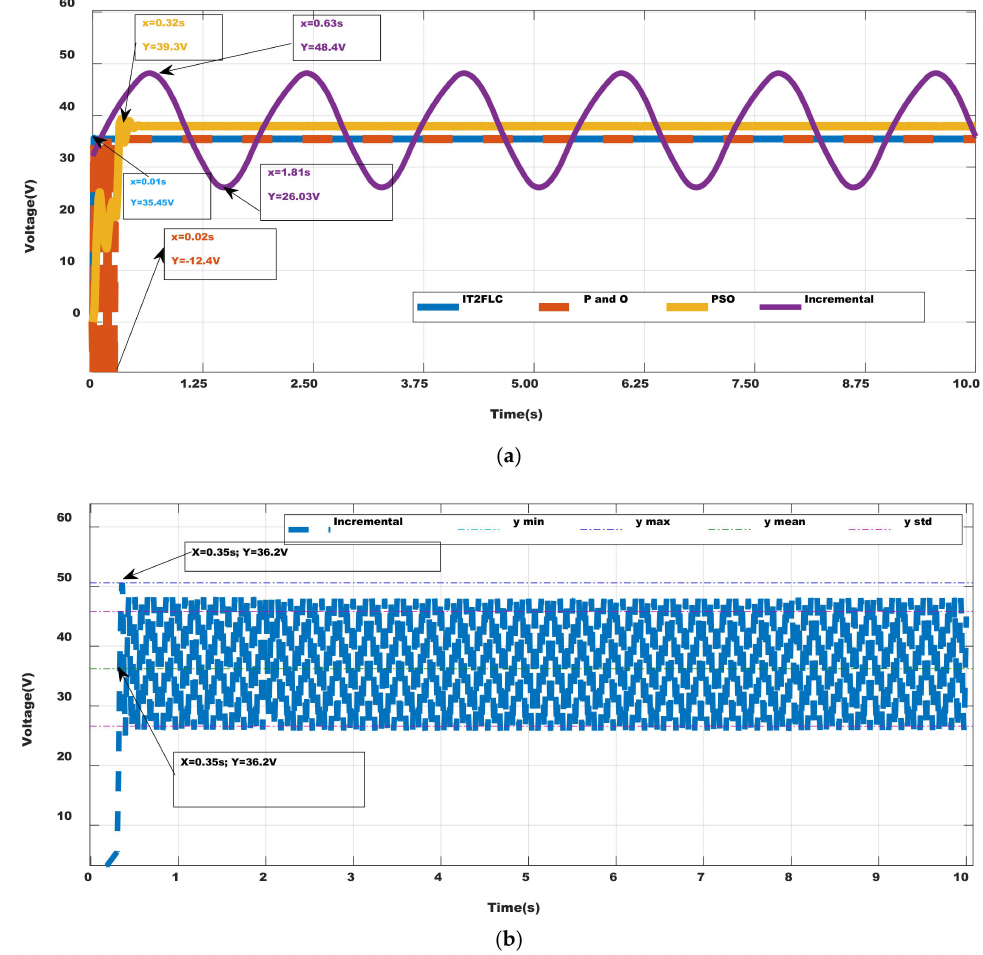
Figure 25. ( a ) Voltage response of all four methods; ( b ) Voltage response of all four